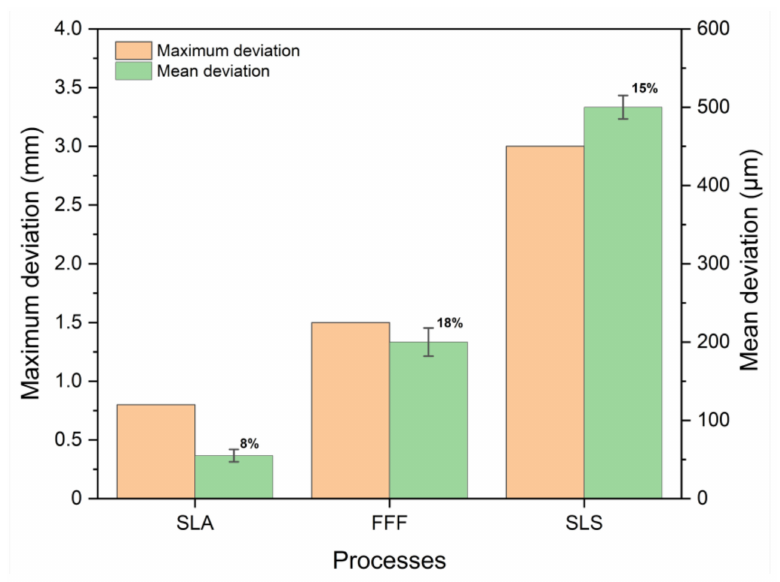
Figure 6. Dimensional deviations of the printed sample 05 from the CAD